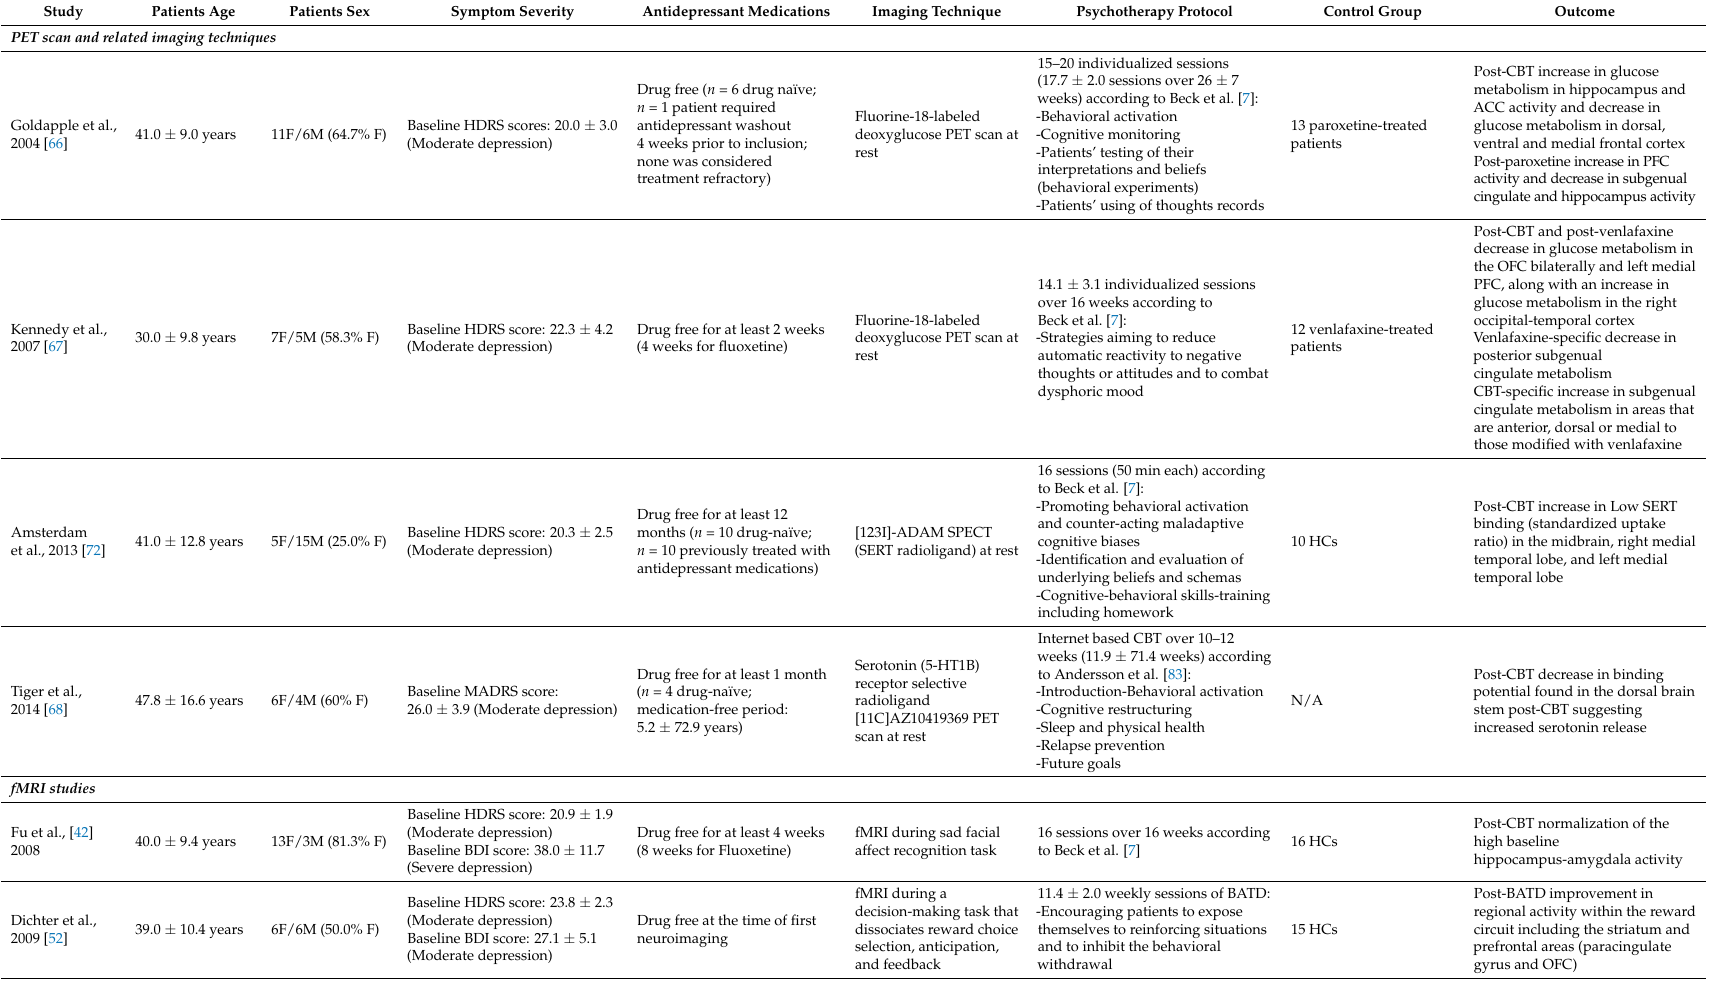
Table A1. Neuroimaging studies assessing cerebral changes following cognitive behavioral